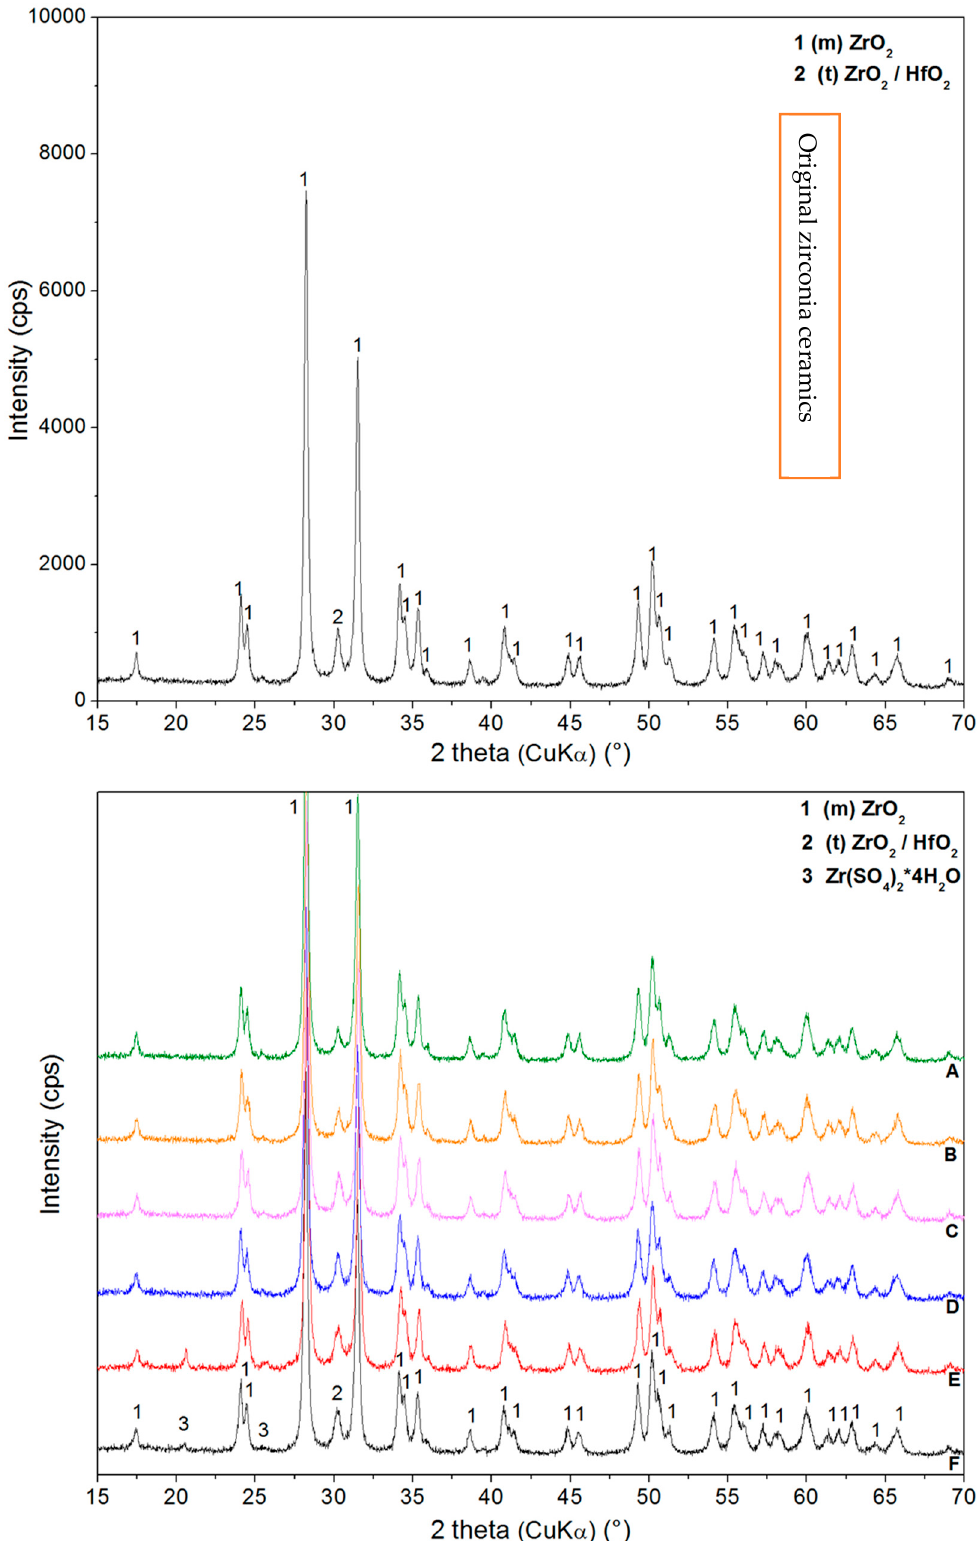
Figure 7. XRD patterns for zirconia: as received sample ( top ) and modified samples ( bottom ): ( A ) ZrO2_HF0.15_120; ( B ) ZrO2_HF0.15_60; ( C ) ZrO2_SN1_120; ( D ) ZrO2_SN1_60; ( E ) ZrO2_PS1_120; ( F ) ZrO2_PS1_60; where peaks of evaluated phases are mentioned in the pattern.